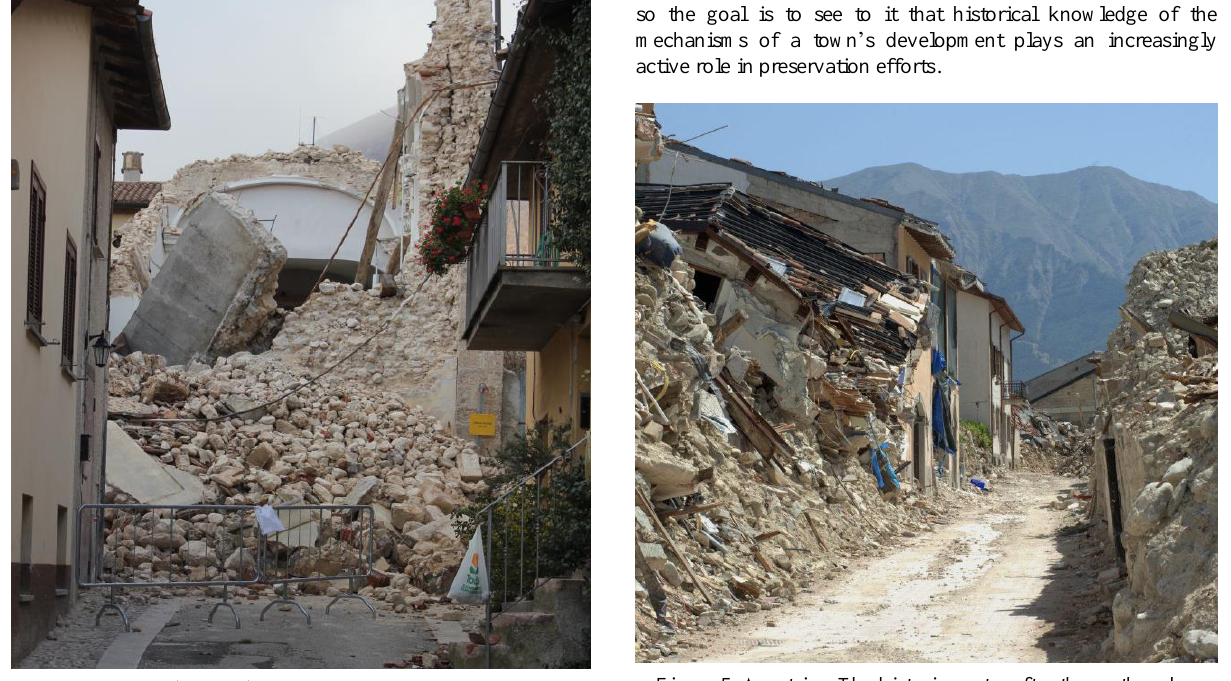
Figure 4. Norcia (Perugia). The collapse of the Crucifix church. Figure 5. Amatrice. The historic center after the